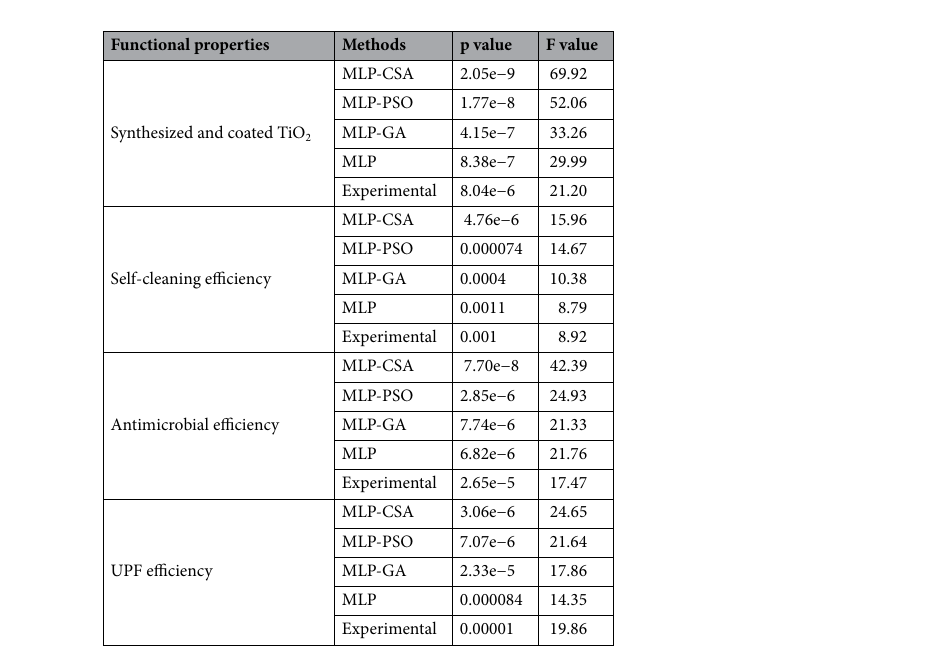
Table 4. Analysis report of the experimental values and the predicted values using MLP, MLP-CSA, MLP-PSO and MLP-GA for functional properties of nano TiO 2 coated cotton.